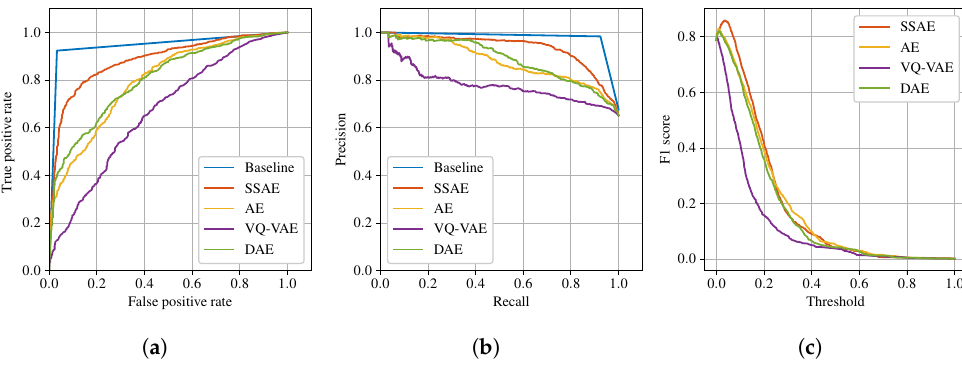
Figure 4. Performance comparison of the autoencoder models SSAE, AE, VQ-VAE and DAE and the baseline YOLOv5. ( a ) ROC curve. ( b ) Precision/recall curve. ( c ) F1 score. The distribution of normal and abnormal samples in the test dataset is shown in Figure 5. In the figure, blue dots correspond to normal samples, orange dots correspond to abnormal samples and red lines represent the thresholds found by optimizing the F1 score. For a good anomaly detector, normal samples should be placed below the threshold line and abnormal samples above the threshold line. The results in Figure 5 support the performance results stated earlier. It can be clearly seen in Figure 5c that VQ-VAE has trouble classifying normal and abnormal samples, since the anomaly scores of a significant number of those samples fall within the same range. However, abnormal samples have higher anomalies scores in general. On the other hand, Figure 5b,d shows that AE and DAE have a good ability of distinguishing between normal and abnormal samples. The SSAE has the best ability to distinguish between the samples, where the majority of normal samples is below threshold and the majority of abnormal samples is above threshold.